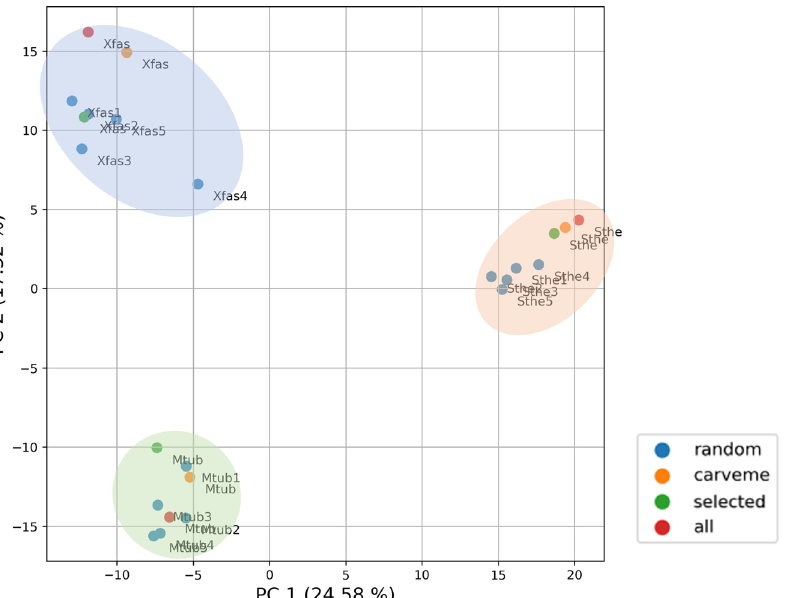
Figure 7: PCA plot of the COG-annotated metabolic functions of all draft models generated by BIT, using different templates, and by CarveMe, for each bacterium. The plot shows the influence of principal components (PC) 1 and 2 on the variability of metabolic features, including the percentage of variance explained by each PC. The dots represent each draft model, and their colour corresponds to the approach used in its reconstruction. Each dot is annotated with the organism-specific identifier, consisting of the first letter of the genus and the first three letters of the species’ second name. The set of models for each organism is surrounded by ellipses that are only used for illustration purposes and do not represent real clusters.